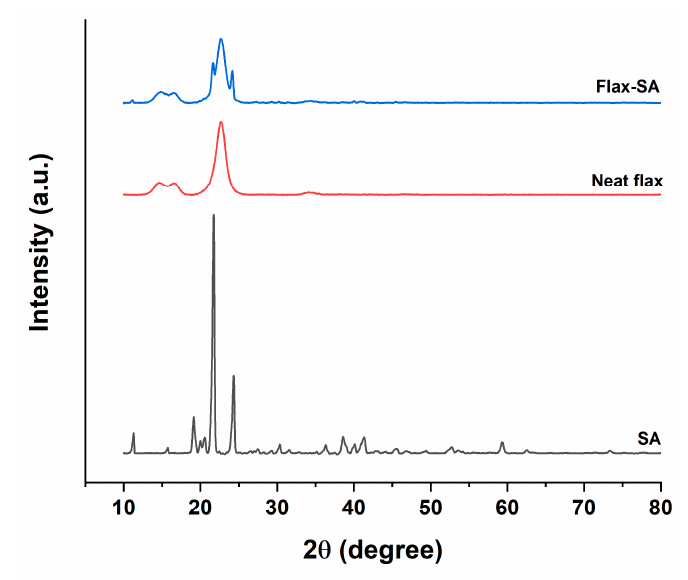
Figure 14. XRD patterns of pure stearic acid (SA), untreated flax fabric (Neat flax), and flax fabric modified with 0.4 M SA